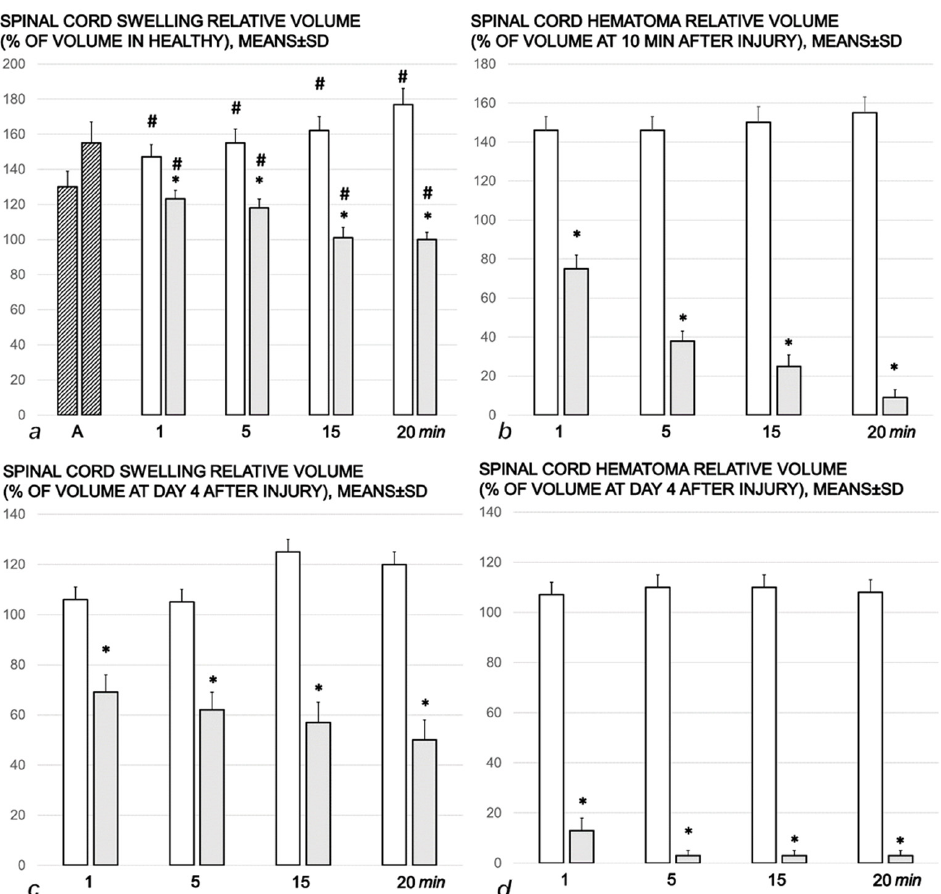
Figure 4. Relative volume of spinal cord swelling and hematoma. Spinal cord injury was induced by 1 min of spinal cord (L2–L3) compression. Upper (early administration) ( a , b ). At 10 min after injury (A) (dashed bars), saline 5 mL/kg ip (white bars), or BPC 157 10 µ g/kg ip (grey bars) were applied, and the effects were assessed at 1 min, 5 min, 15 min, and 20 min intervals ( a ). Spinal cord swelling was assessed relative to healthy values (100%). Spinal cord hematoma was assessed relative to a hematoma at 10 min following injury (100%) just before therapy application ( b ). Low (delayed administration) ( c , d ). At day 4 after injury, saline 5 mL/kg ig or BPC 157 10 ng/kg ig were applied, and the effects were assessed at 1 min, 5 min, 15 min, and 20 min intervals. Spinal cord swelling ( c ) and hematoma ( d ) were assessed relative to values at day 4 (100%), just before therapy application. Means ± SD, * p < 0.05, at least vs. corresponding control; # p < 0.05, at least vs. values at 10 min after injury (A) (100%).